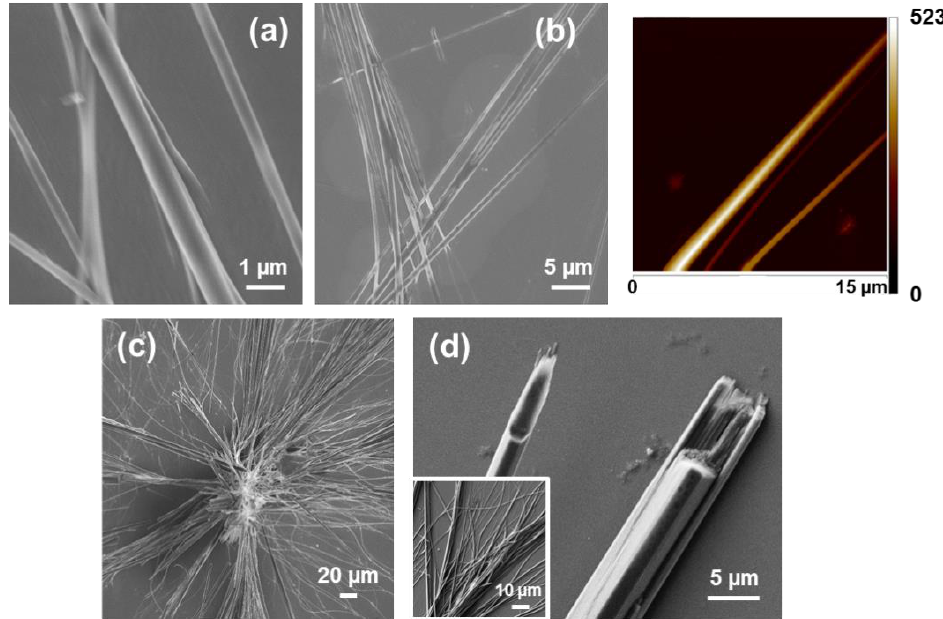
Figure 2. ( a – d ) SEM and ( b , right) AFM images of nano- and microtubular structures obtained from FF solutions in ( a ) 1:49 HFIP:water (0.1 mg/mL), ( b ) 1:99 HFIP:water (0.05 mg/mL), ( c ) 1:4 HFIP:water FF solutions in ( a ) 1:49 HFIP:water (0.1 mg / mL), ( b ) 1:99 HFIP:water (0.05 mg / mL), ( c ) 1:4 HFIP:water (1 mg/mL), and ( d ) 1:9 HFIP:EtOH (0.5 mg/mL) mixtures. (1 mg / mL), and ( d ) 1:9 HFIP:EtOH (0.5 mg / mL)